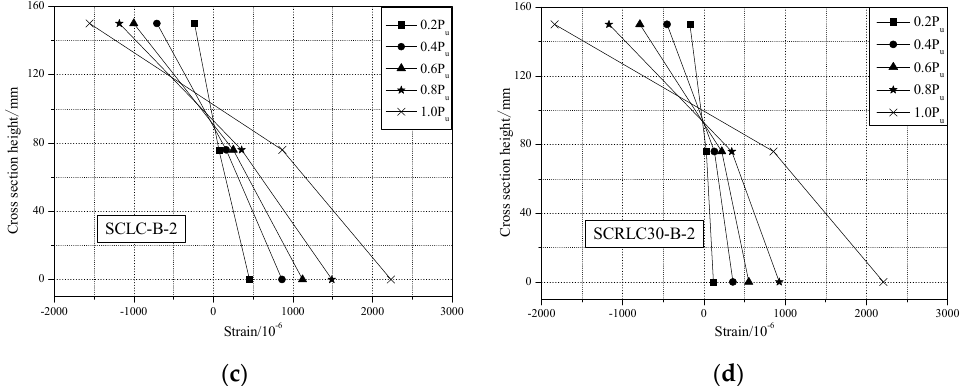
Figure 13. Sectional strain distribution at mid-span for di ff erent composite slab specimens. ( a ) SCLC-B-1, ( b ) SCRLC30-B-1, ( c ) SCLC-B-2, ( d ) SCRLC30-B-2.